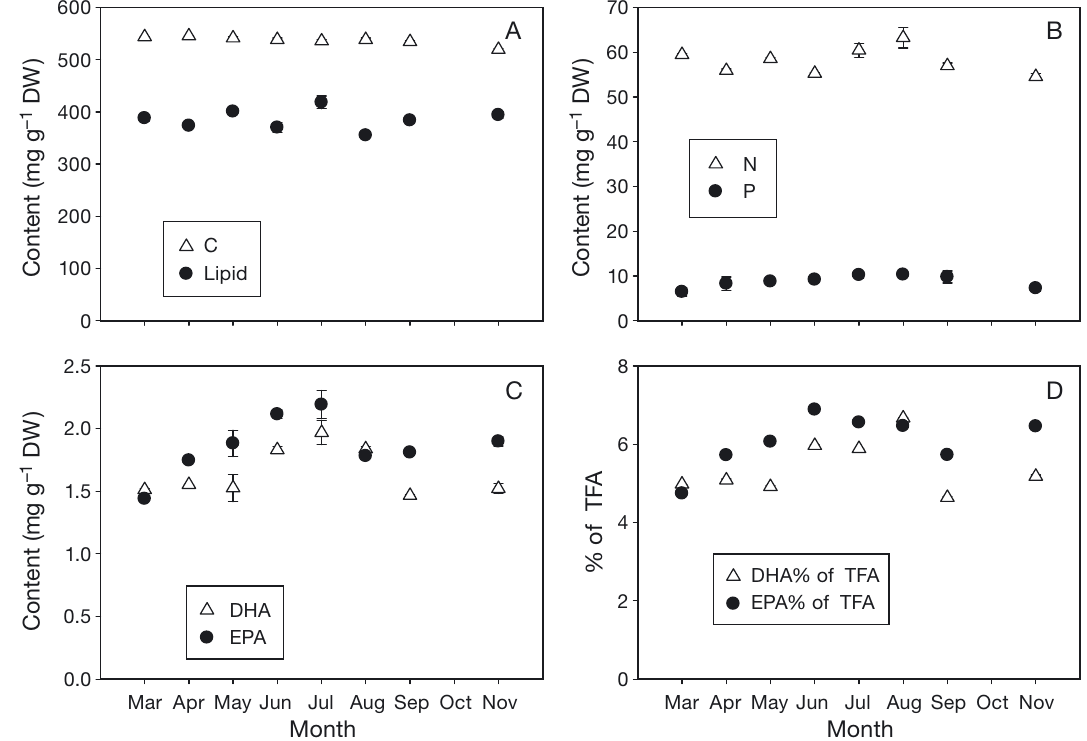
Fig. 4. Chemical contents per gram dry weight (DW) of feed used to feed Cage S and Cage L. (A) Carbon and lipid content; (B) nitrogen and phosphorus content; (C) docosahexaenoic acid (DHA) and eicosapentaenoic acid (EPA) contents; and (D) per- centage of DHA and EPA in total fatty acid (TFA) content. Error bars show ±1